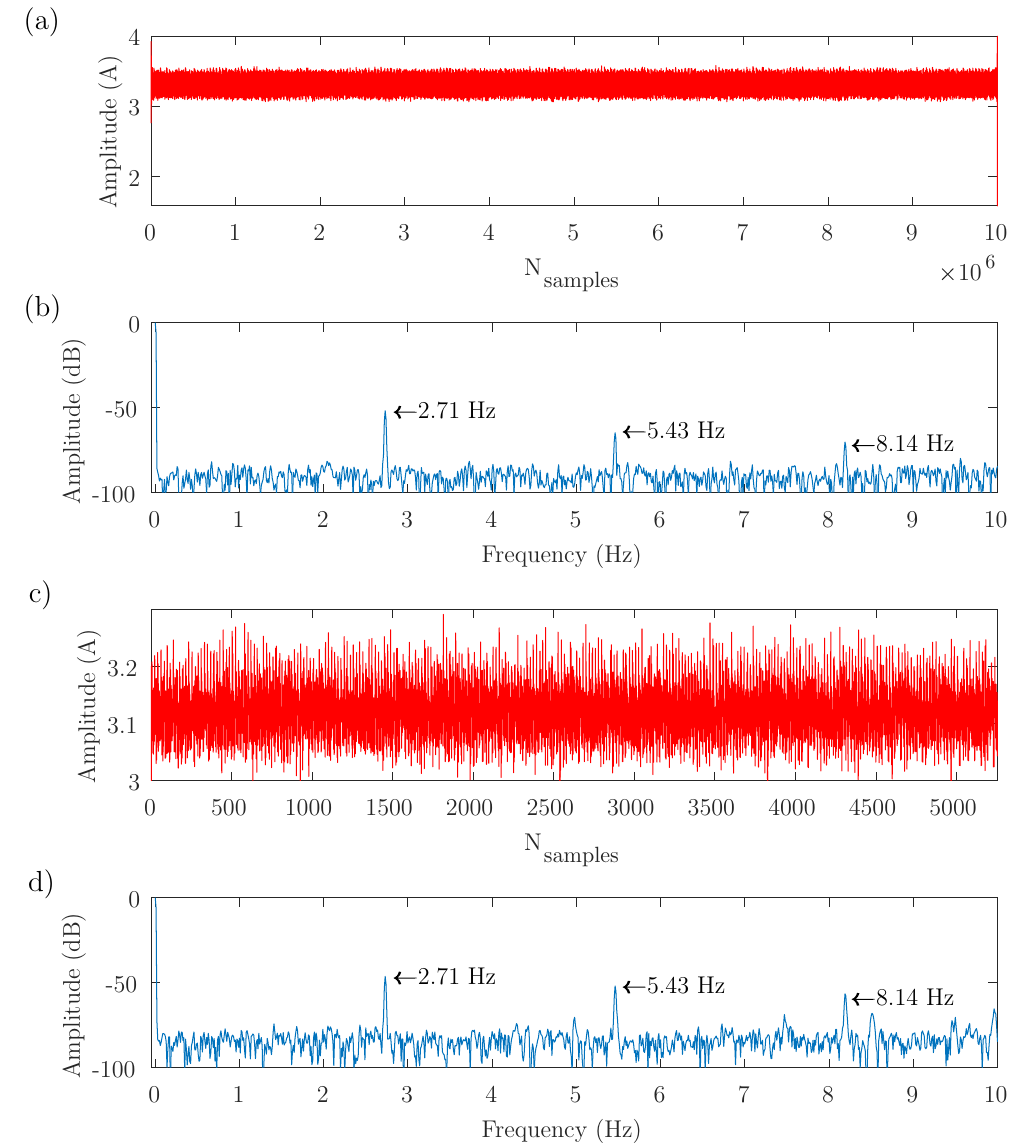
Figure 5. Test 2. Motor fed through the Siemens VSD in SVC mode, a reference speed of 1530 r/min, and a load equal to 35% of its rated load (frequency output = 26.22 Hz, speed = 1530 r/min, slip = 0.0271 p.u.). ( a ) Full-length current envelope (10 7 samples) and its spectrum ( b ), showing the three first